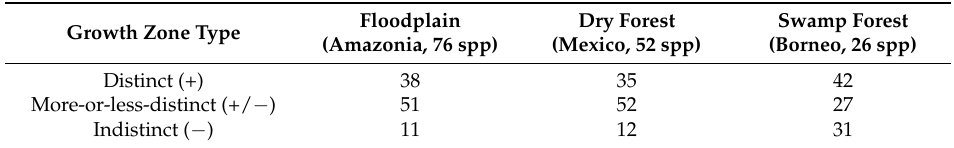
Table 2. Percentage of species from different sites and forest types, showing distinct (+), more-or-less-distinct (+/ − ) or indistinct ( − ) growth zones. Data from Amazonian floodplain forests [10], dry forest in Mexico [29], and swamp forest (this study). Floodplain Dry Forest Growth Zone Type (Amazonia, 76 spp) (Mexico, 52 spp) Distinct (+)